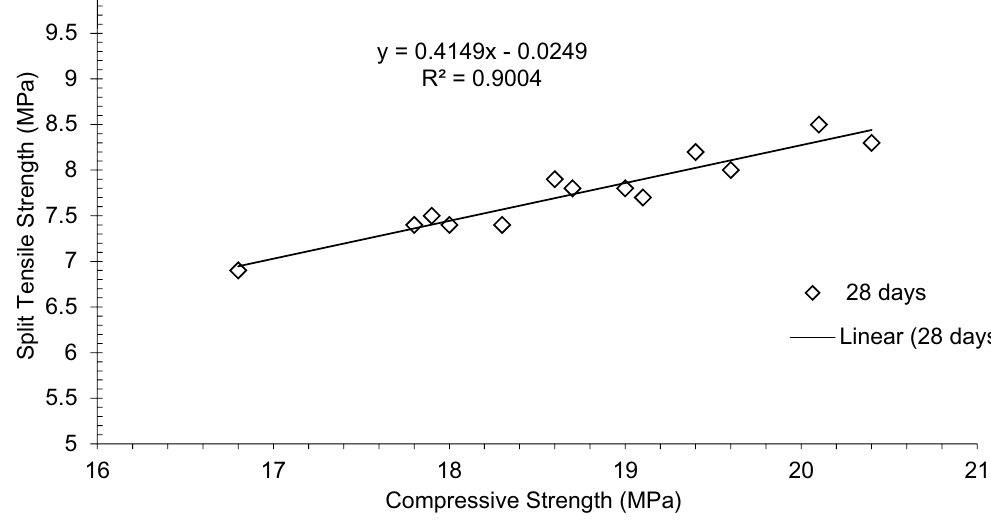
Figure 13. Co-relation between compressive and split tensile strength.